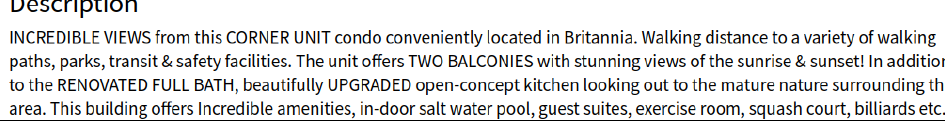
Figure 2. An example of the textual description found on a real estate website for a given